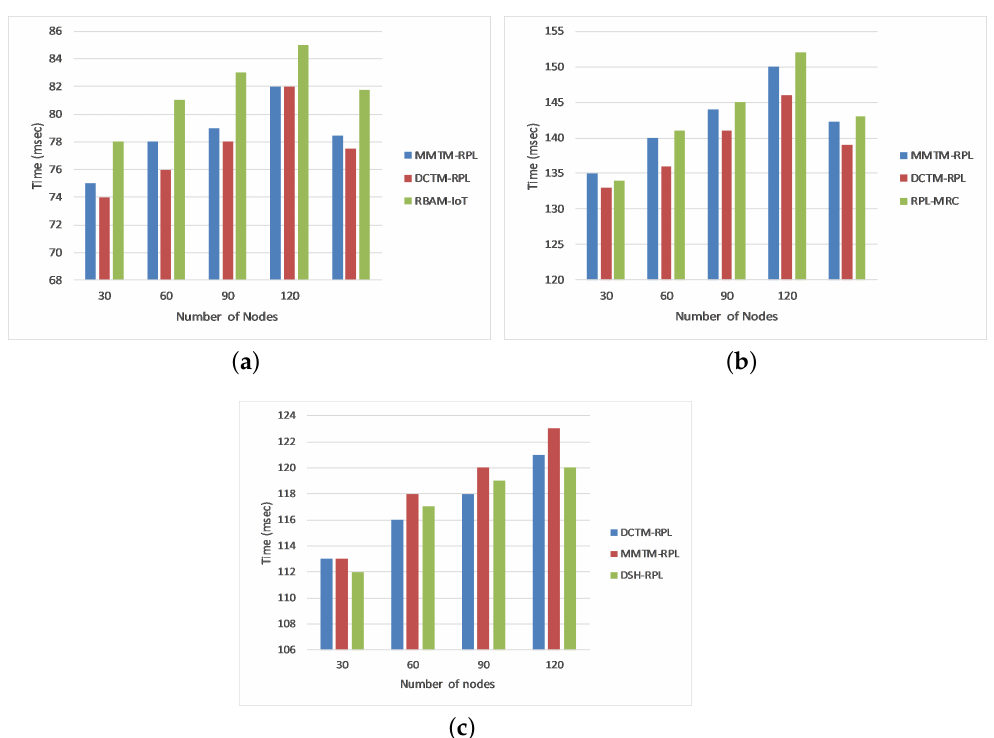
Figure 9. Comparison of end-to-end delay for different attacks: ( a ) Rank attack, ( b ) Sybil attack, and ( c ) Sinkhole